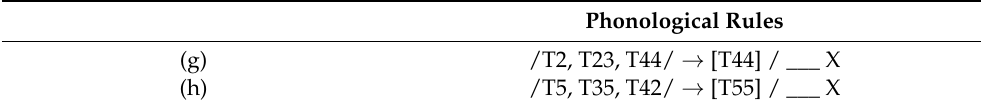
Table 4. Sandhi rules in Xiapu Min. “X” = any of the seven lexical tones in Xiapu Min (The rules are based on Wen (2015) and modified based on fieldwork data collected by the